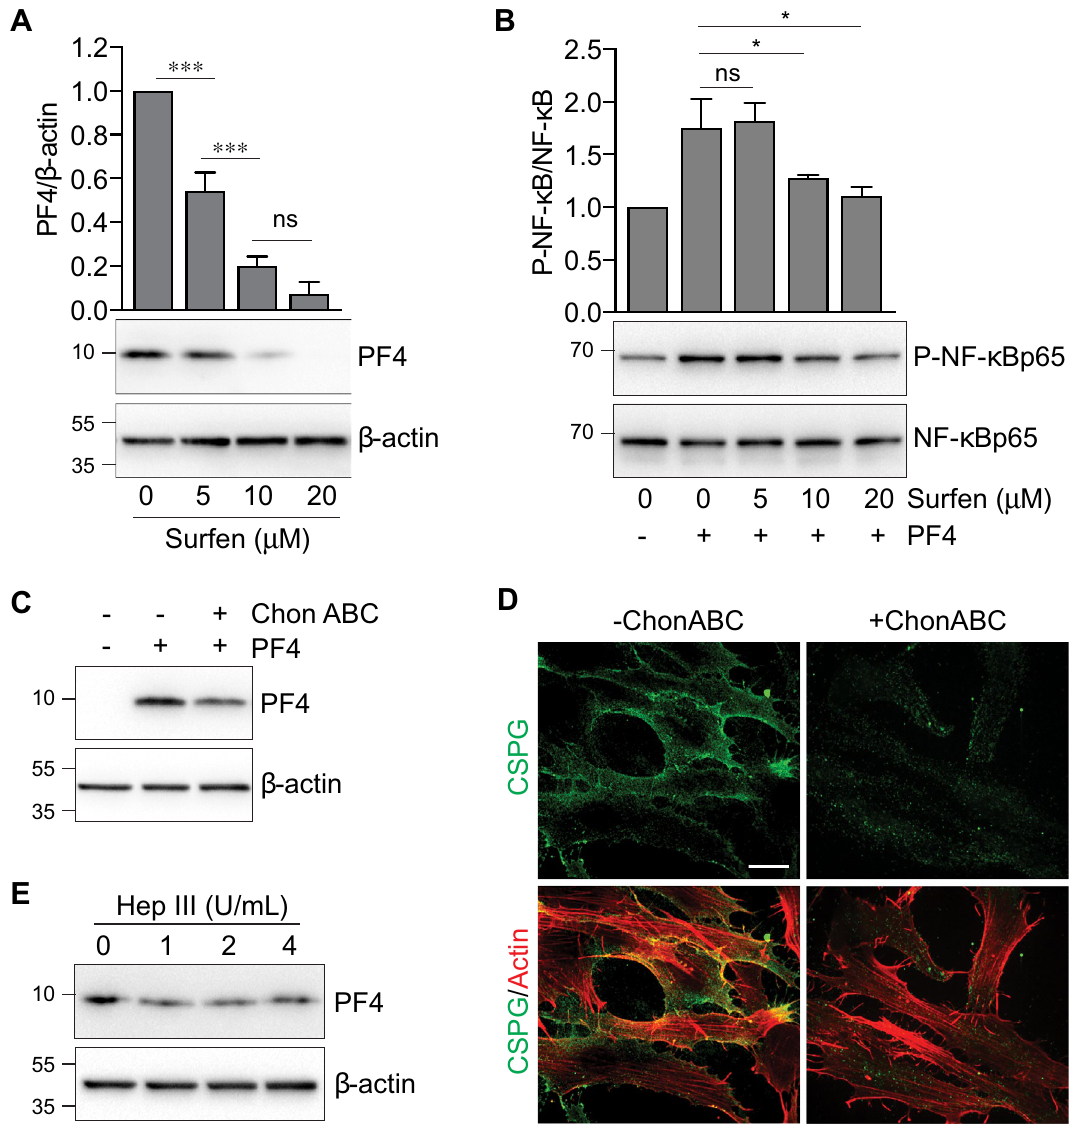
Figure 5. Removal of surface glycosaminoglycans (GAGs) blocks PF4 uptake and NF-κB signaling. ( A ) Serum-starved cells were incubated with various concentrations of the heparan sulfate antagonist Surfen at the indicated concentrations prior to treatment with recombinant PF4 (2 μg/mL) for 30 min. Whole cell lysates were resolved by SDS-PAGE and immunoblots were probed with an anti-PF4 antibody. β-actin is shown as a loading control. Top: bar graph depicts the intracellular PF4 uptake, expressed as the ratio of PF4:β-actin. Data are expressed as mean ± SD and represent three independent experiments. ***, p<0.001, based on ANOVA and Tukey’s post-hoc multiple comparison tests. ( B ) Serum-starved cells were incubated with various concentrations of the heparan sulfate antagonist Surfen at the indicated concentrations prior to treatment with recombinant PF4 (2 μg/mL) for 30 min. Whole cell lysates were resolved by SDS-PAGE and immunoblots were probed with an antibody against phospho-NF-κB p65 (serine 536). Total NF-κB p65 is shown as a loading control. Top: bar graph depicts NF-κB phosphorylation, expressed as the ratio of phospho-NF-κB:NF-κB. Data are expressed as mean ± SD and represent three independent experiments. *, p<0.05, based on ANOVA and Tukey’s post-hoc multiple comparison tests. ( C ) Cells were cultured in the absence (−) or presence (+) of chondroitinase ABC (Chon ABC, 0.5 U/mL) prior to treatment with PF4 (2 μg/mL) for 30 min. Whole cell lysates were resolved by SDS-PAGE and immunoblots were probed with an anti-PF4 antibody. β-actin is shown as a loading control. ( D ) Confocal micrographs illustrate surface chondroitin sulfate in cells cultured in the absence (−) or presence (+) of chondroitinase ABC, prior to fixation and immunostaining for chondroitin sulfate proteoglycan (CSPG, green) and actin (red). Bar = 20 μm. ( E ) Cells were cultured in the absence or presence of heparinase III at the indicated concentrations, prior to treatment with PF4 (2 μg/mL) for 30 min. Whole cell lysates were resolved by SDS- PAGE and immunoblots were probed with an anti-PF4 antibody. β-actin is shown as a loading